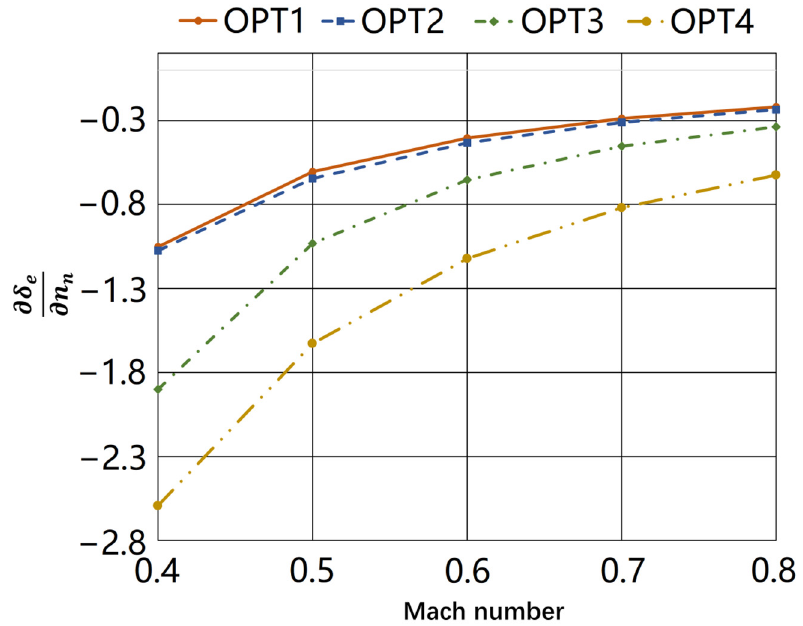
Figure 14. The control authority of the four configurations at different Mach number.